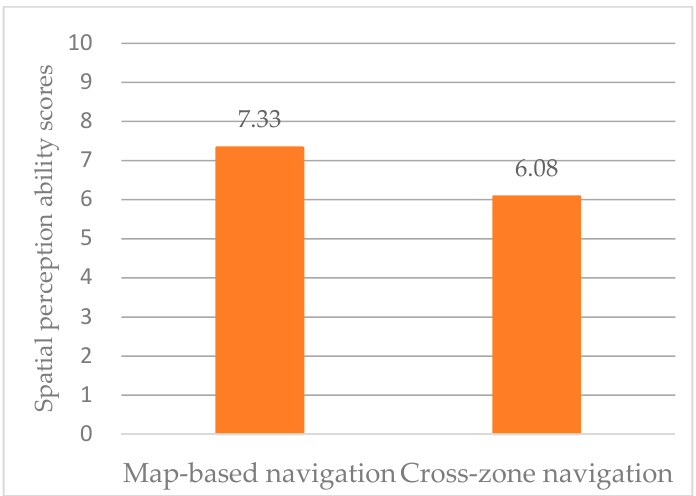
Figure 6. Spatial perception ability scores for map-based navigation and cross-zone navigation groups.